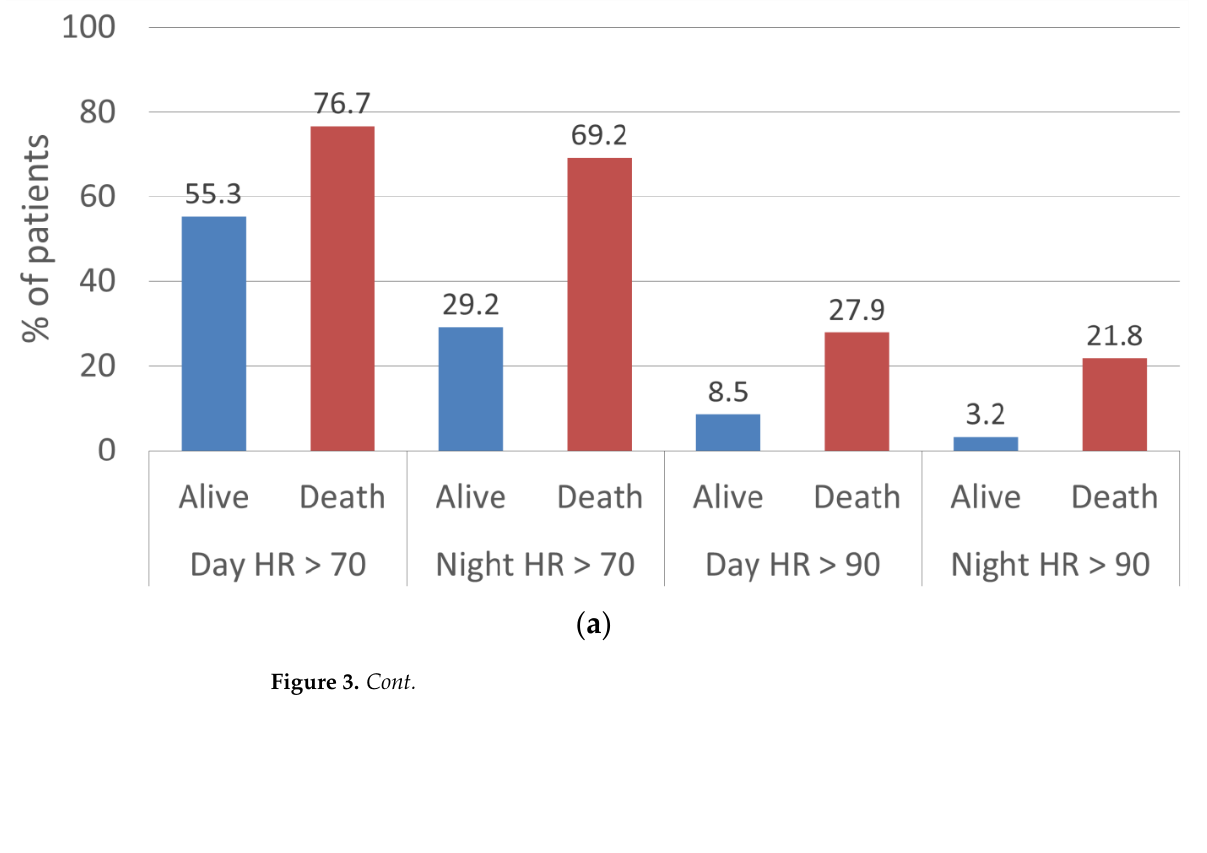
Table 4. Nighttime HR trend with different thresholds.